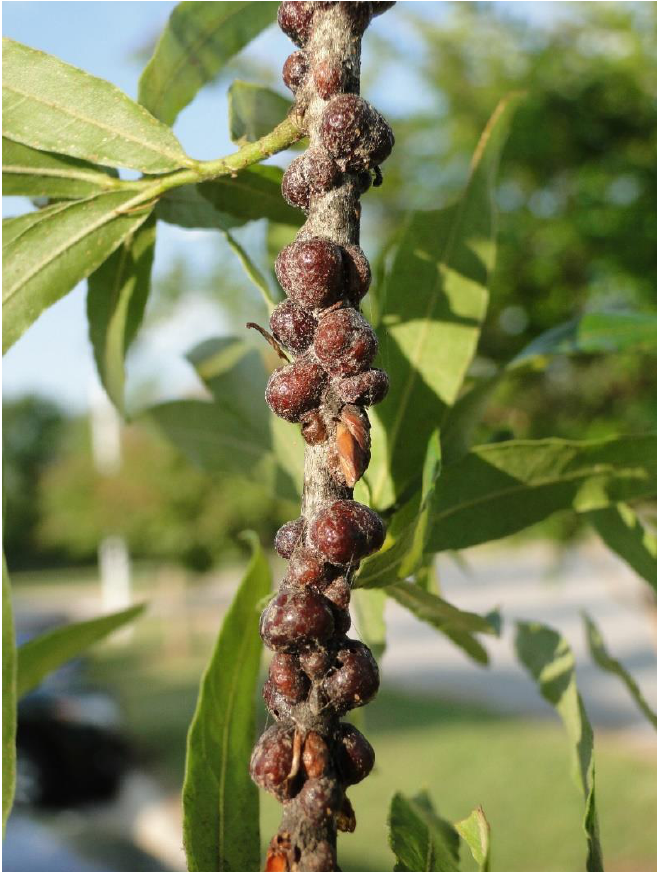
Figure 1. Willow oak ( Quercus phellos ) branch heavily infested with oak lecanium scale ( Parthenolecanium quercifex ) ovisacs. Photo: Clyde Sorenson, North Carolina State University.